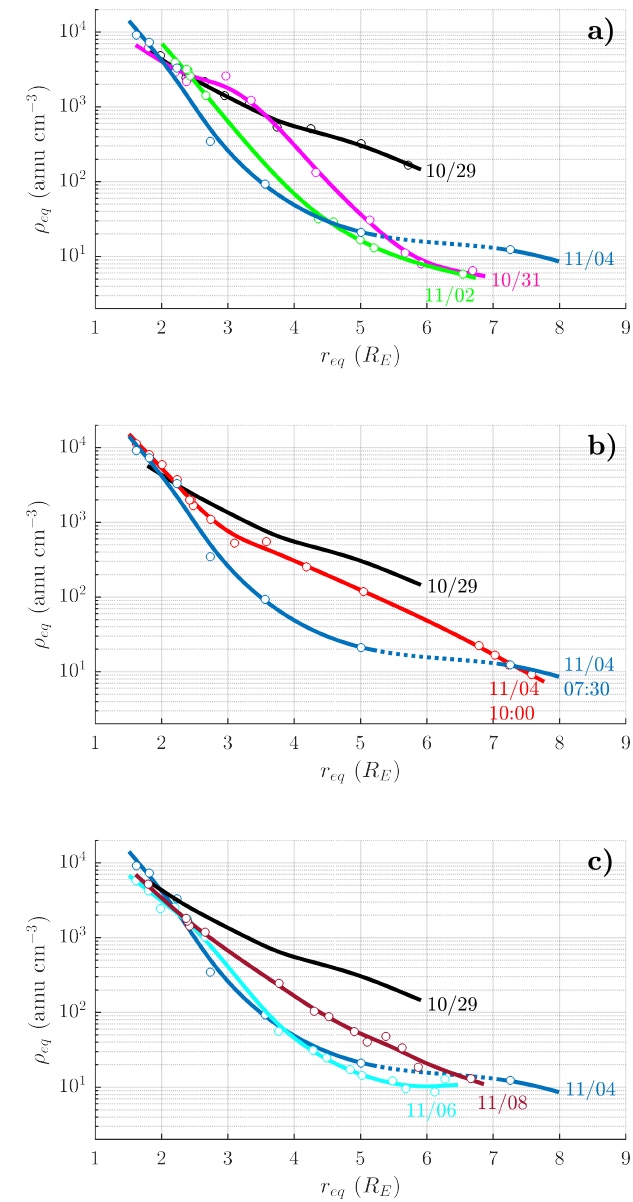
Figure 4. Radial plasma mass density profiles on selected days. ( a ) Plasmasphere erosion from 29 October to 4 November. ( b ) Possible plume crossing during the main phase of the storm on 4 November. ( c ) Plasmasphere partial recovery in the interval 4–8 November. All the profiles but the red one on panel b refer to 07:30 UT. The red profile is taken at 10:00 UT. Solid lines are the fit obtained from EMMA density estimates (open circles). Dashed curves are the fit portions obtained between EMMA points separated by a radial distance larger than 2 R E . Those parts of the fit are not used to evaluate the time series in Figure